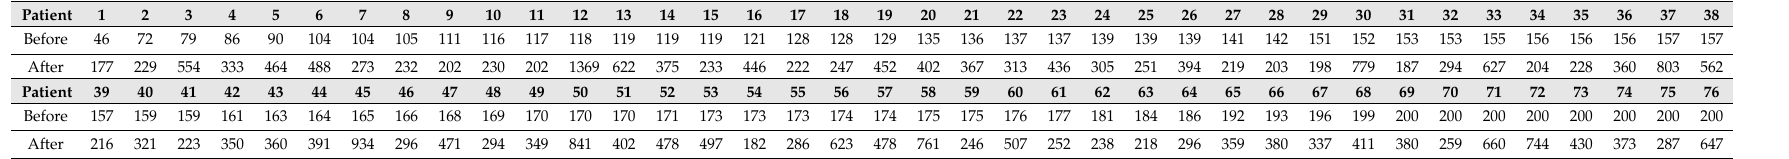
Table 4. Serum cobalamin levels (pg/mL) before and after acute treatment with oral